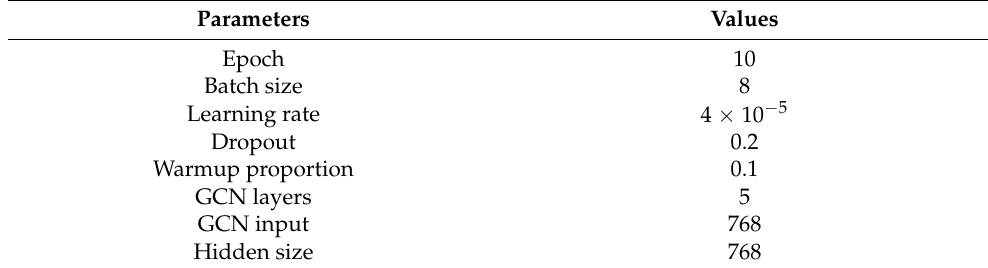
Table 2. Parameter configurations of our